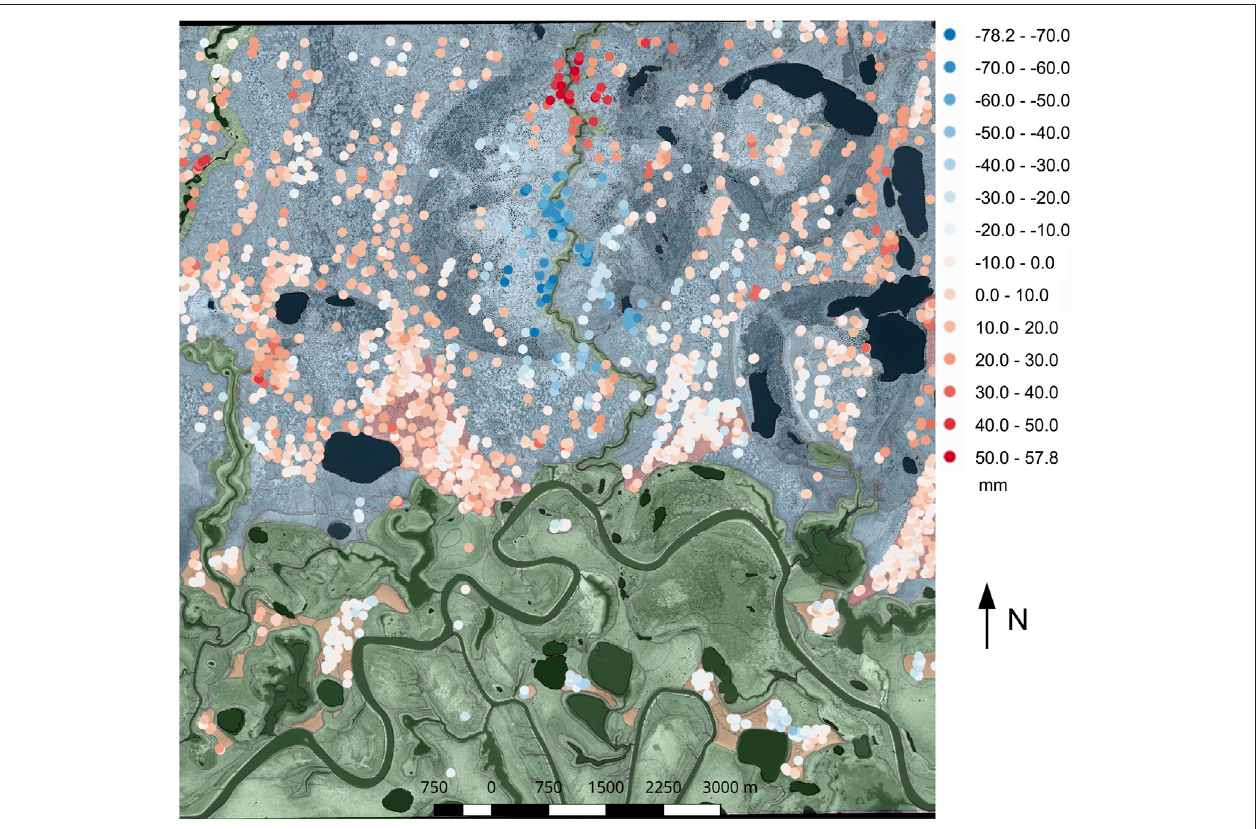
FIGURE 10 | Cumulative thawing season surface displacement over 3 years; subsidence ( − ) and heave (+) velocities in mm. Background: 2019 Worldview image with landform class ( Figure 4 ). See also Supplementary Figure S5 for cumulative displacement of every year and Supplementary Figure S2 for average surface displacement velocities over 3 years. WorldView © 2019